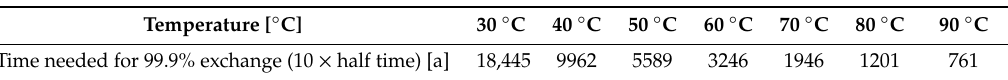
Table 2. Time needed for 99.9% exchange of O in the bisulphate-water system calculated at pH 7 using the formula of McKentzie and Truesdell [24]. a = year.